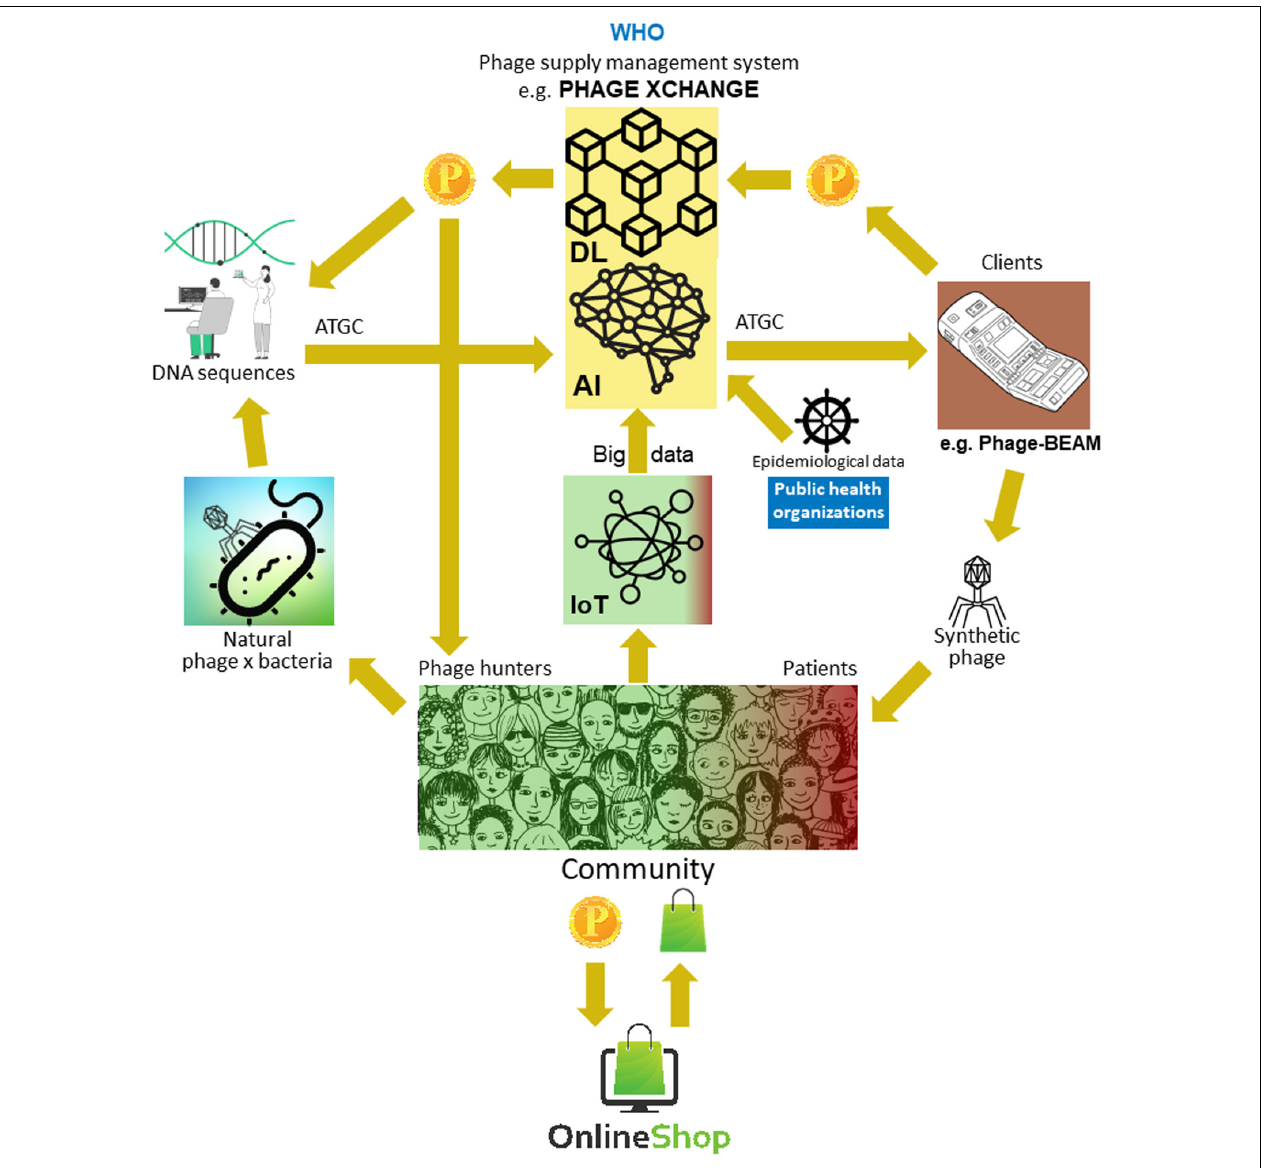
FIGURE 2 | Vision of how the phage supply chain might be organized in 2035. AI, artificial intelligence; ATGC, DNA sequence; BEAM, bedside energized anti-microbial; DL, distributed ledger; IoT, Internet of Things; P, PhageCoin; WHO, World Health Organization.